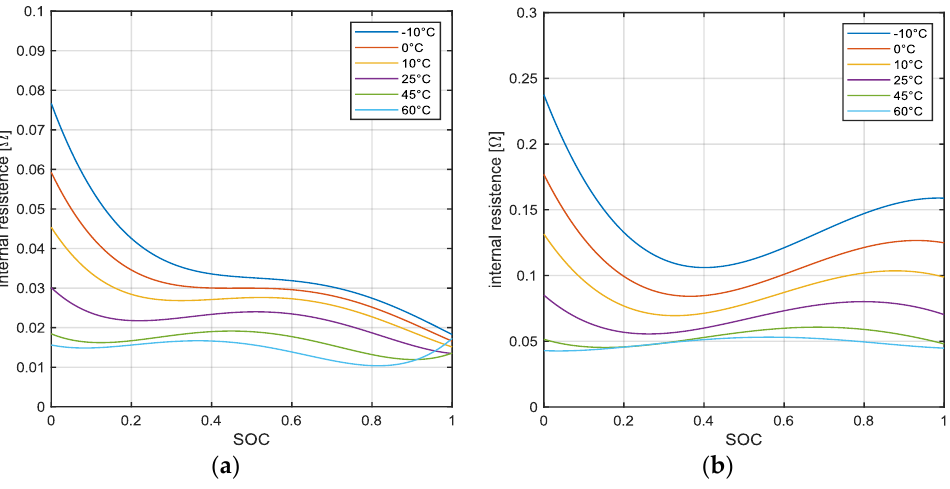
Figure 7. Equivalent internal resistance model of the NMC ( a ) and NCA ( b ) cells.